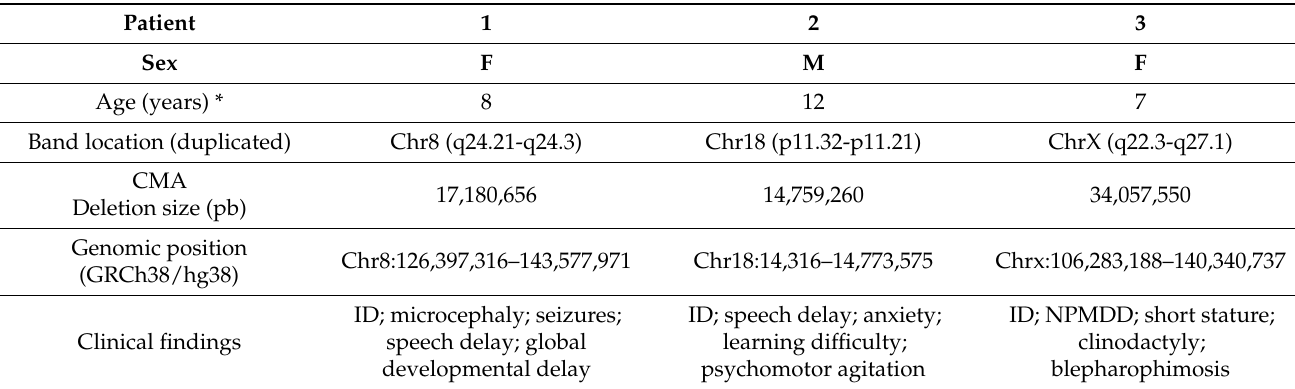
Table 1. Summary of the CMA and clinical findings from the 3 patient with chromosomal duplications.